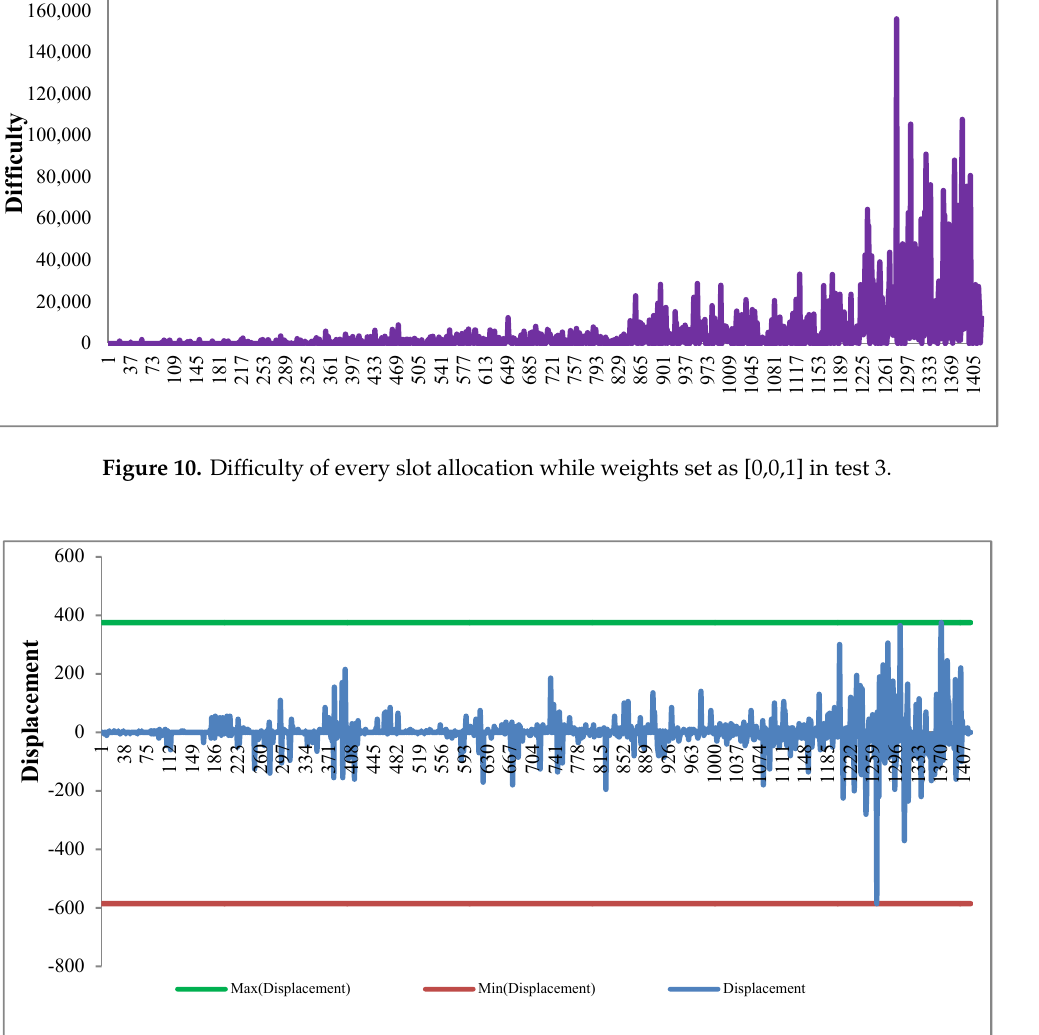
Figure 11. Displacement while weights set as [0,0.5,0.5] in test 8.